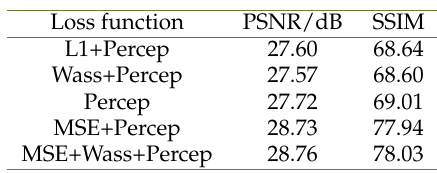
Table 3. PSNR/SSIM values denoised by different loss